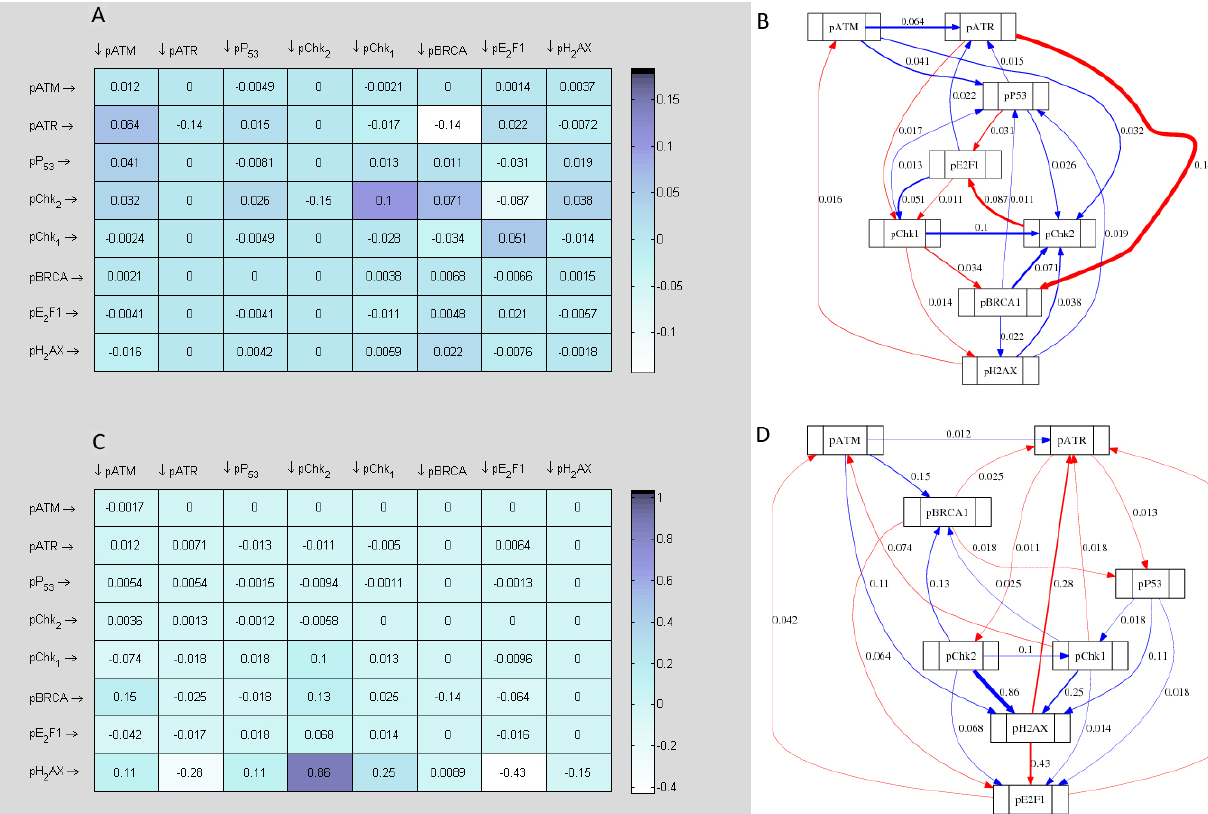
Figure 12. Constructed network models of time series data of the DDR pathway: (A) - inferred interaction matrix of 0 . 4 µ M DOX time series data (without ATM inhibition); (B) - derived topological map (network of interactions) of 0 . 4 µ M DOX time series data (without ATM inhibition); (C) - inferred interaction matrix of 0 . 4 µ M DOX+KU time series data (with ATM inhibition); and (D) - derived topological map of 0 . 4 µ M DOX+KU time series data (with ATM inhibition). These derived networks of interactions (in C and D) do not fully reflect the irregularity and oscillatory patterns observed in the predicted dynamics shown in Figures 14 and 16. It seems that multiple time invariant model (i.e. biphasic) representations may be more appropriate for characterising these data (i.e. 0.4 µ M DOX and 0.4 µ M DOX+KU) rather than single representations.